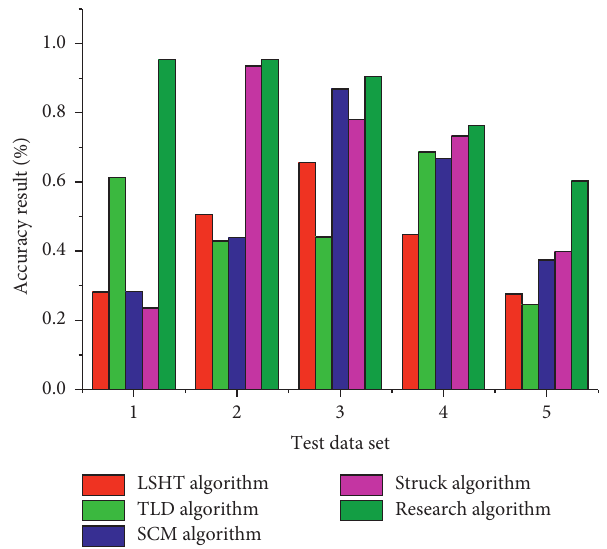
Figure 3: Accuracy comparison experimental